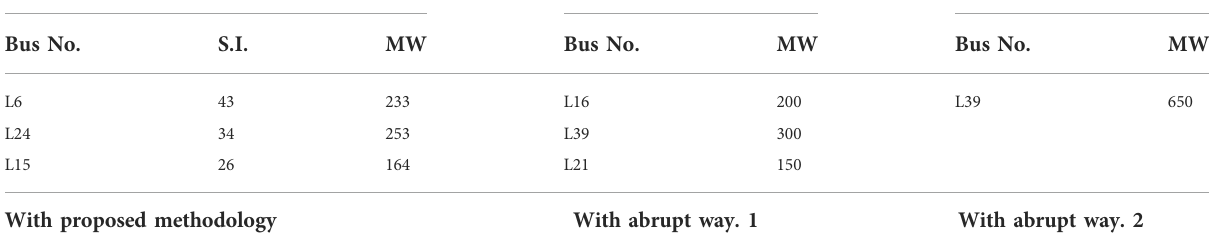
With proposed methodology With abrupt way. 1 With abrupt way. 2 Bus